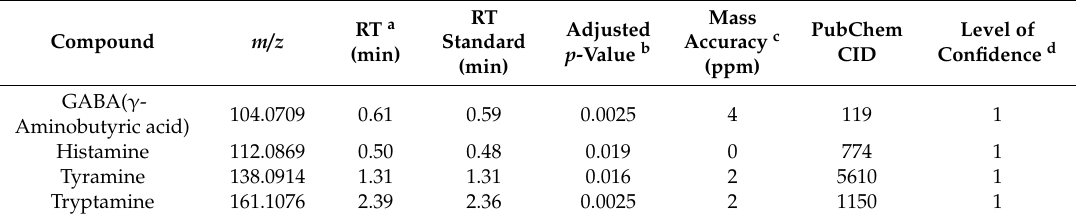
Table 3. Biogenic amines significantly elevated in digests of fermented sausages compared to digests of non-processed pork. All compounds were identified by comparison of exact mass, retention time and MS/MS fragmentation pattern to those of chemical standards.